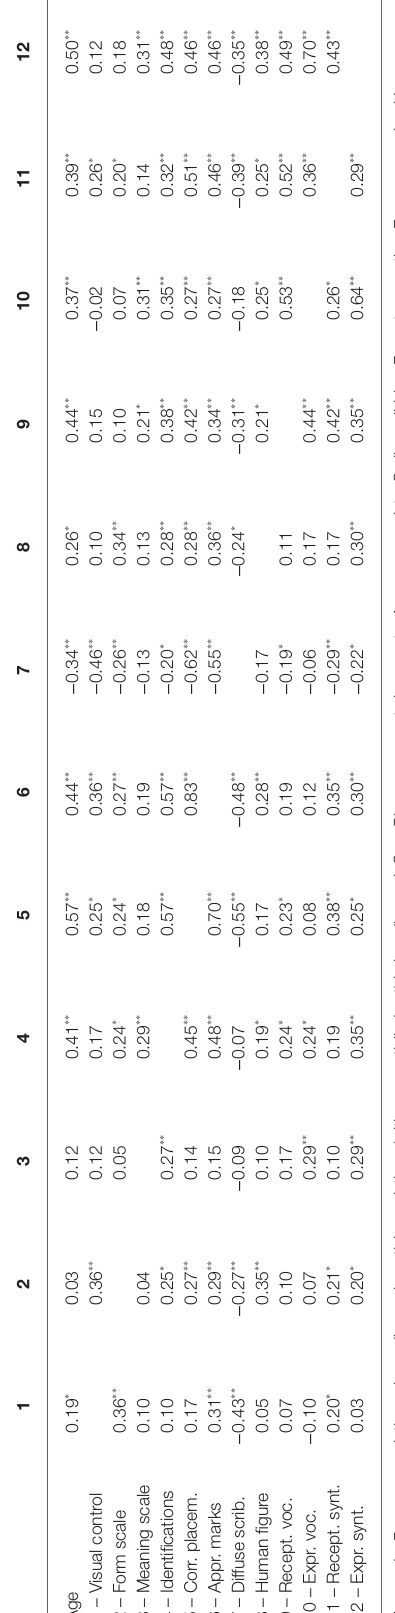
TABLE 6 | Factor loadings and structure matrix in the exploratory factor analysis of language and drawing measures. Pattern matrix (factor Structure matrix loadings) (correlations)